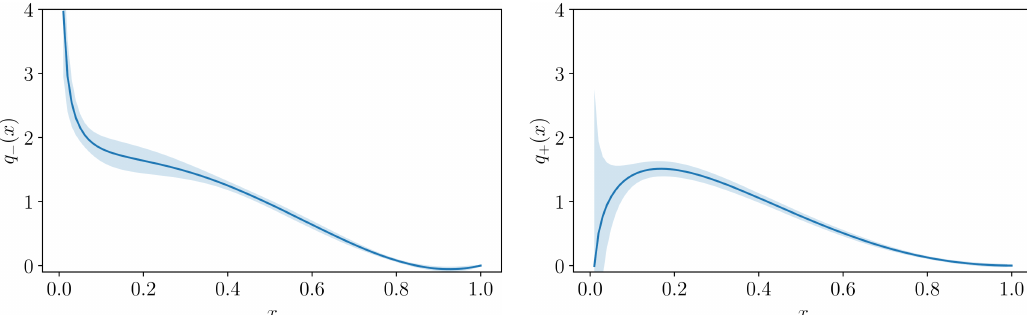
Figure 12 . The results of the AICc weighted average of the models of section 6.3.